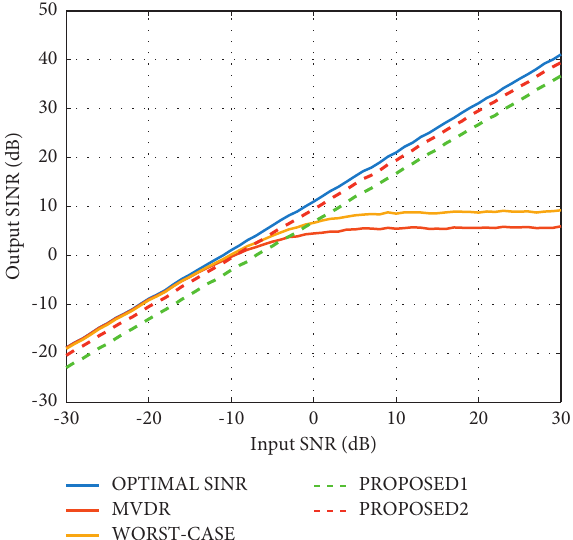
Figure 2: CA: output SINR versus the input SNR.